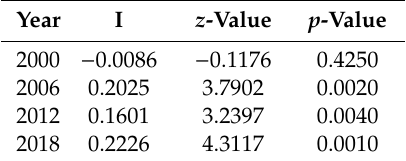
Table 3. GUECL Moran’s I value and significance test results in the Yellow River